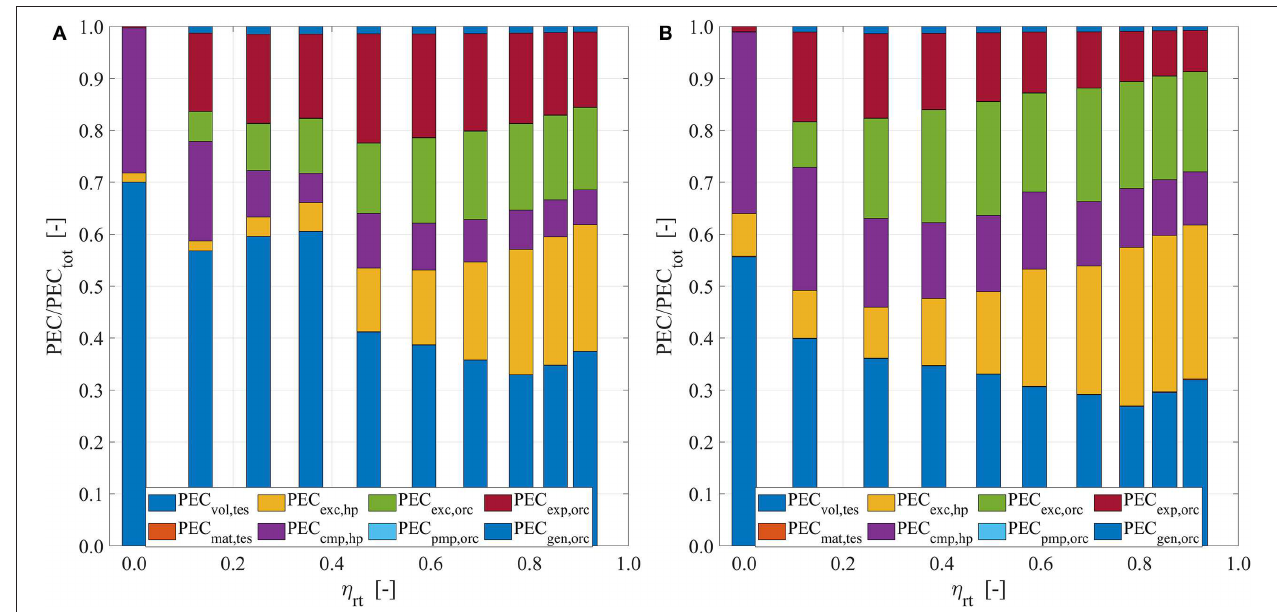
FIGURE 4 | Total cost relative composition. Results are reported for T in , src = 80 ◦ C and τ ch = 6h and (A) ˙ W hp . = 500 kW el and (B) ˙ W hp . = 5,000 kW el .